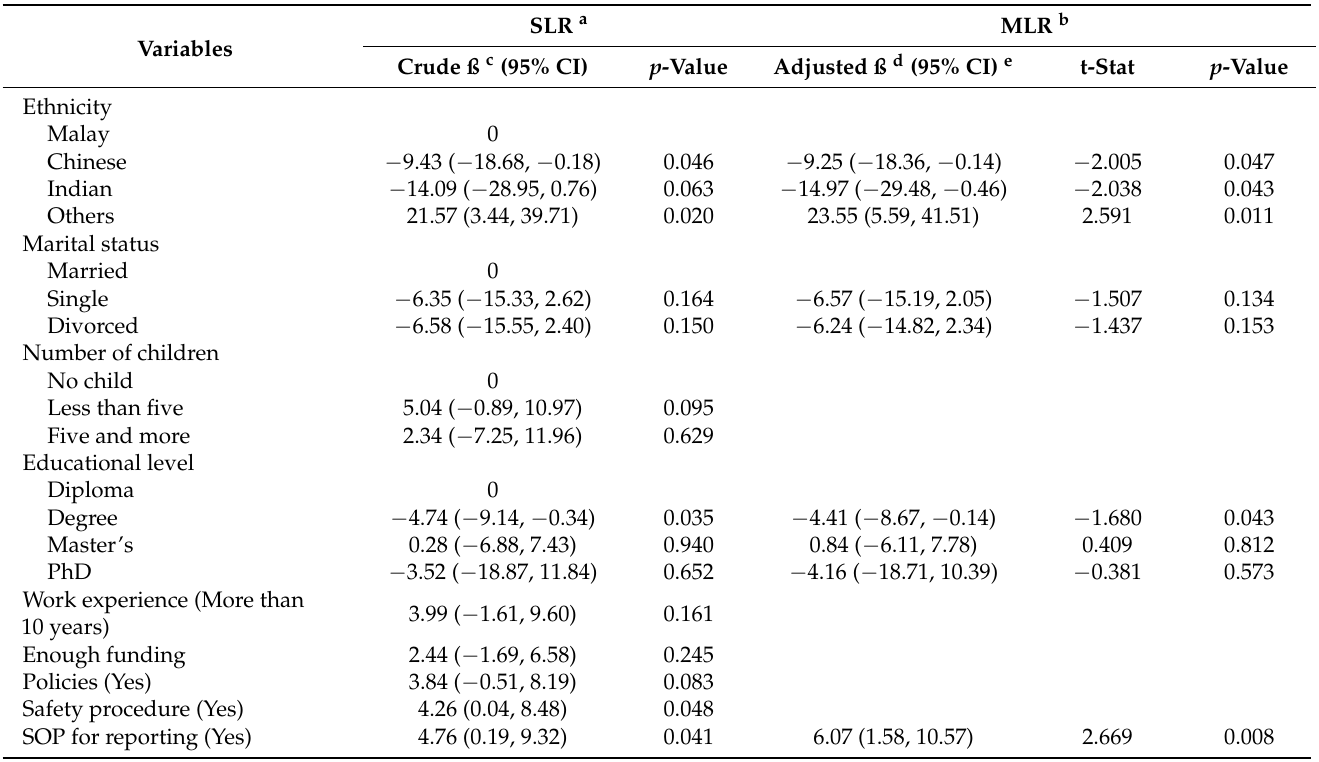
Table 7. Factors associated with practice towards WPV prevention among employers at healthcare facilities in Melaka ( n =